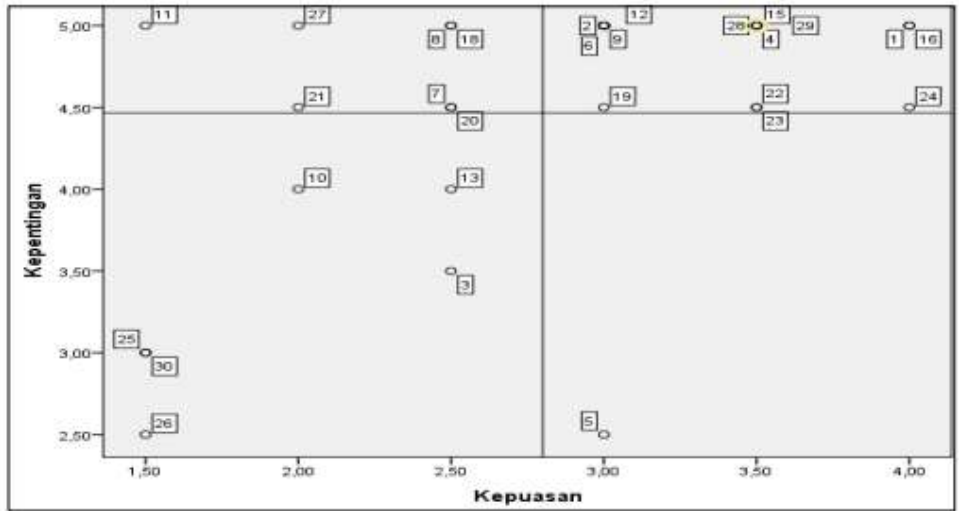
Figure 3. Result of Importance Performance Analysis of Central Bangka Source: Processed,